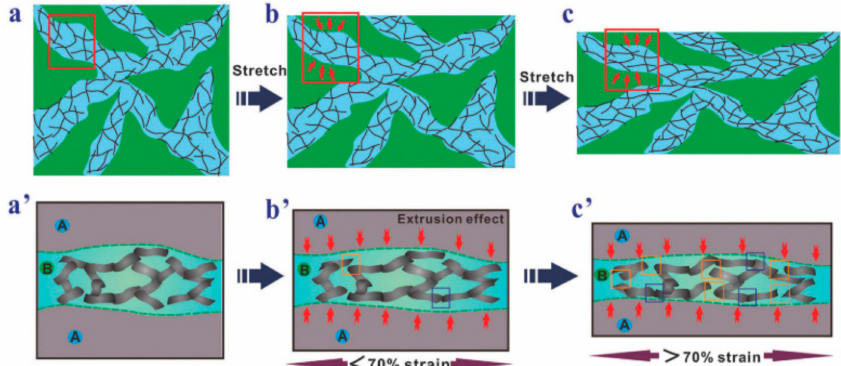
Figure 13. Formation of the conductive network in GRPCs subjected to stretching. ( a ) State without stretching; ( b ) State with stretching being less than 70%; ( c ) State with stretching being more than 70%; ( a’ ), ( b’ ) and ( c’ ) are the corresponding magnified images of the region in the rectangular shapes. Reproduced with permission from the authors of [136]. They Royal Society of Chemistry.